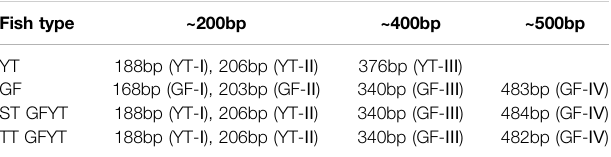
TABLE 4 | Results of 5S rDNA